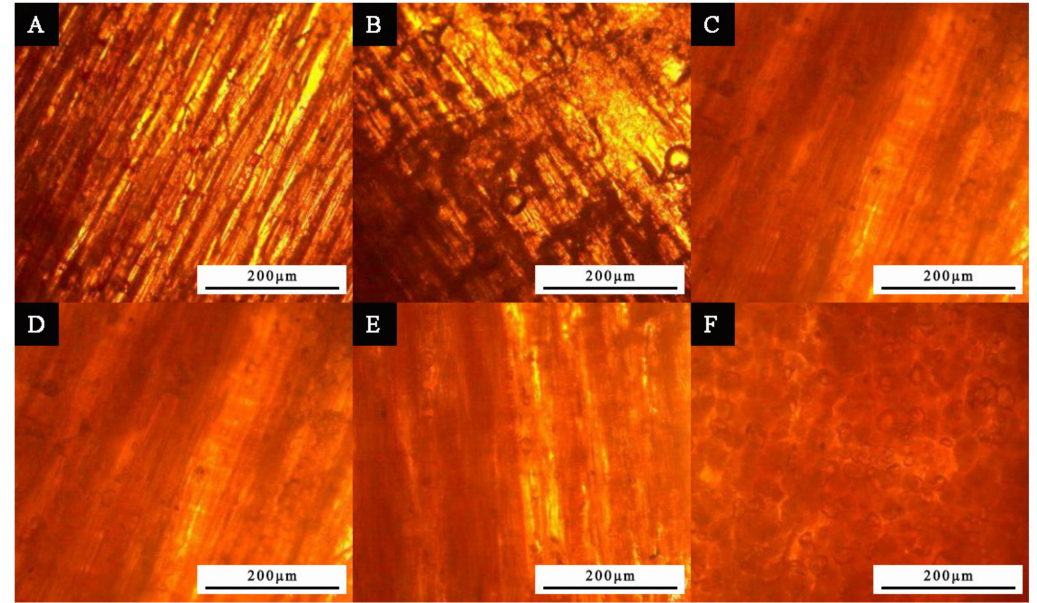
Figure 3. Microstructure of paint film with different contents of nano-silver solution: ( A ) 1.0%, ( B ) 4.0%, ( C ) 7.0%, ( D ) 10.0%, ( E ) 13.0%, and ( F ) 16.0%.